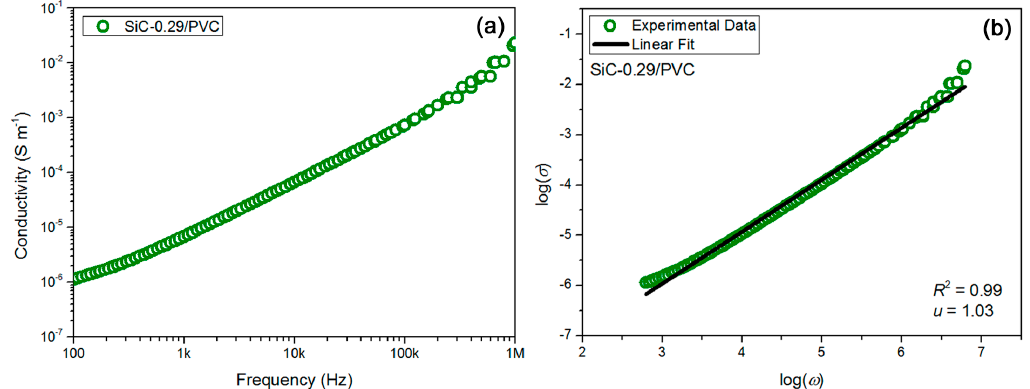
Figure 5. ( a ) AC conductivity result proved the high insulation property for SiC-0.29/PVC sample, and ( b ) linear fitting of measured data showed an elevated u value of 1.03 for this sample and also confirmed contribution of induced polarization as ca.